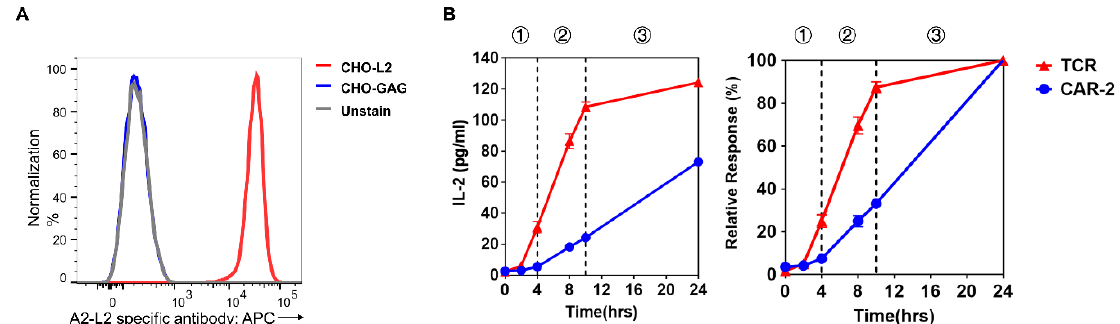
Figure 3. IL-2 production kinetics of CAR and TCR. ( A ) Expression of HLA*A02:01-L2 by CHO-APC. The TCR-like antibody was used to detect the expression and specificity. CHO-L2 and CHO-GAG refers to CHO-APC presented antigenic LMP2 A peptide and irrelevant GAG peptide, respectively. ( B ) IL-2 production of CAR-T and TCR-T upon stimulation by CHO-APC. The IL-2 production of TCR is separated by 3 phases, labeled as 1, 2, 3 in the graph, representing the acceleration, stable, and deceleration phases, respectively. The amount of IL-2 production in the left panel is calculated as a percentage and shown in the right panel. Data are representative of at least three independent experiments, plotted as mean ± SD of technical triplicates.